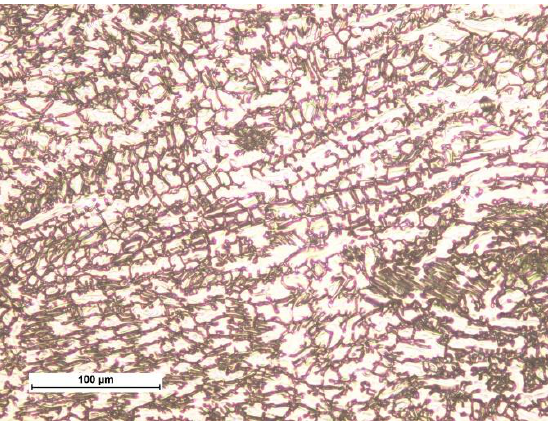
Figure 4. Microstructure of austenitic intermediate layer. Table 4. Chemical composition and properties of the abrasion-resistant layer of ABRADUR 64-covered electrodes.